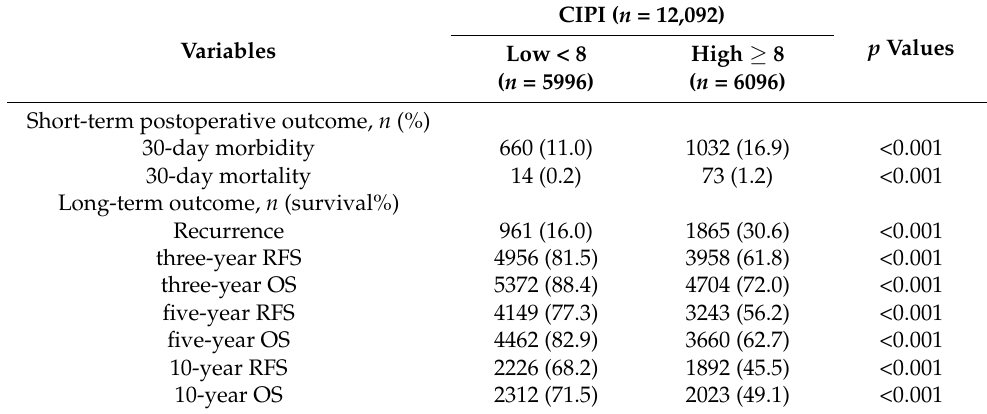
Table 2. Association of CIPI with short- and long-term